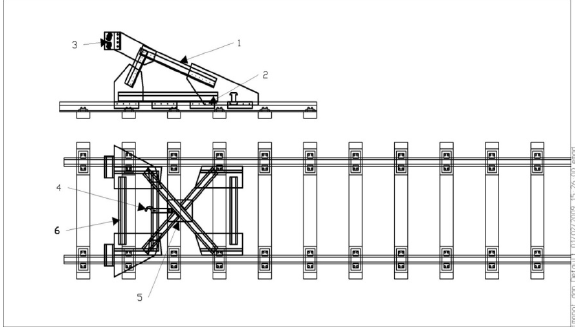
Figure 3. Friction buffer stop without additional brakes [8]